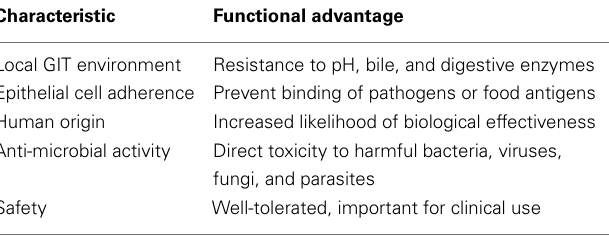
Table 1 | Characteristics of an ideal